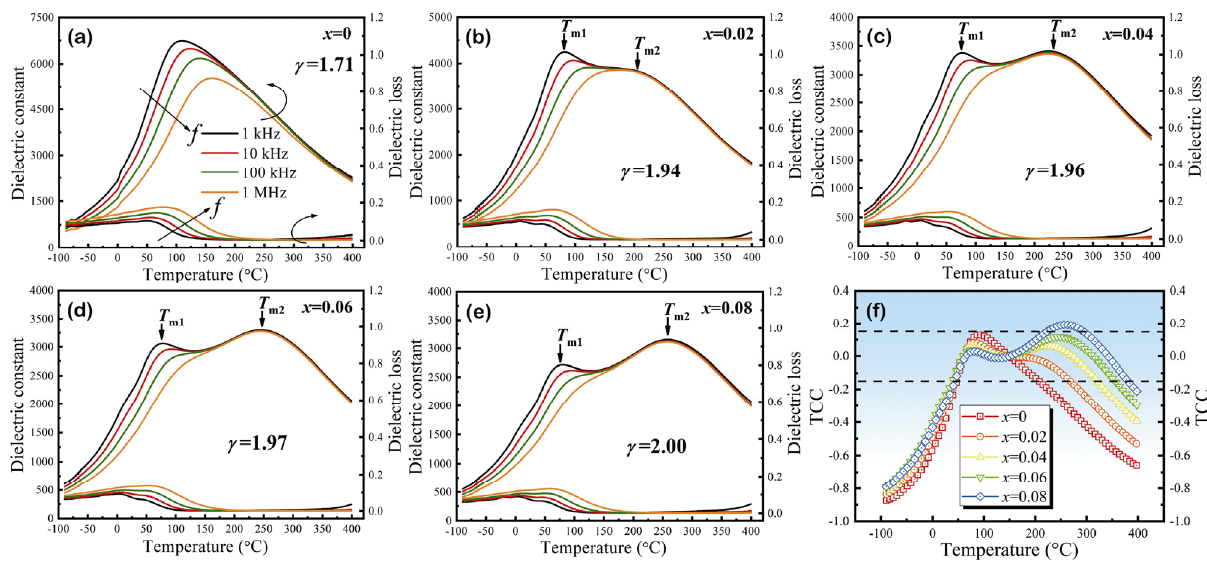
Fig. 4 Temperature dependent dielectric constants and loss of BNS 0.245 − 1.5 x (cid:0) 0.5 x B 0.325+ x T ceramics at typical frequencies: (a) x = 0, (b) x = 0.02, (c) x = 0.04, (d) x = 0.06, and (e) x = 0.08; and (f) TCC for BNS 0.245 − 1.5 x (cid:0) 0.5 x B 0.325+ x T ceramics with different x values by choosing 150 as ℃ the based temperature.